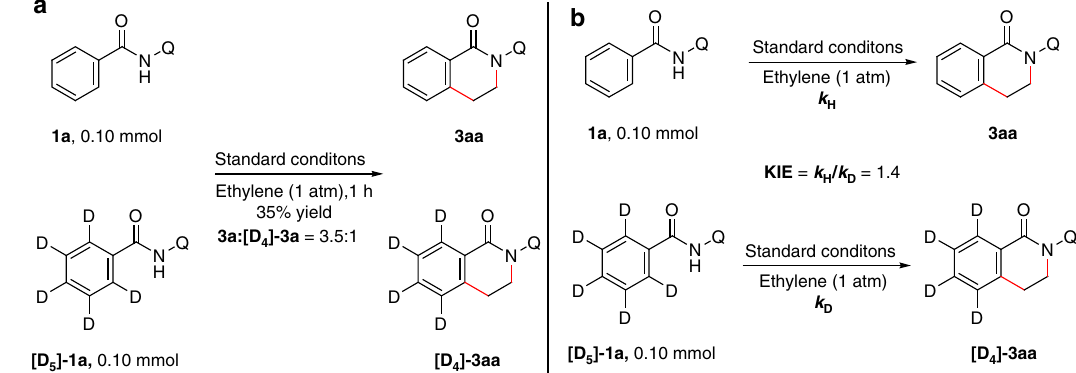
Fig. 4 Kinetic isotope effect experiments. a Intermolecular competition experiment between 1a and [D 5 ]-1a . b Parallel reactions with 1a and [D 5